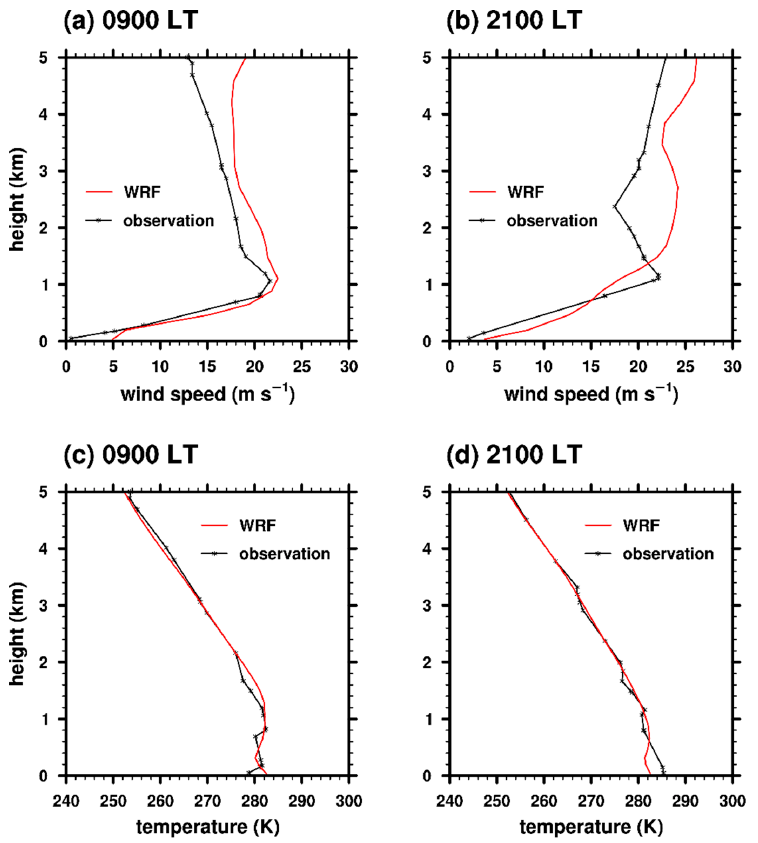
Figure 3. Vertical profiles of wind speeds at ( a ) 0900 LT and ( b ) 2100 LT and temperatures at ( c ) 0900 LT and ( d ) 2100 LT at Osan station. The black and red lines indicate the radiosonde observation data and WRF simulation data, respectively.